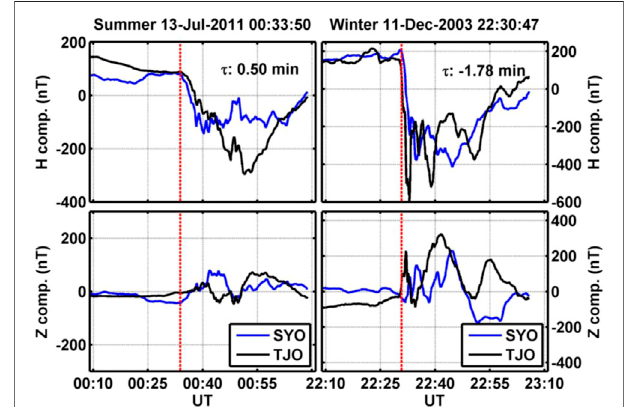
FIGURE 9 | Format of this fi gure is approximately the same as Figure 2 . The left side shows a summer solstice event and the right side shows a winter solstice event. The blue curve is associated with SYO, and the black curve shows the data from TJO. The red dashed line shows the onset time at SYO.